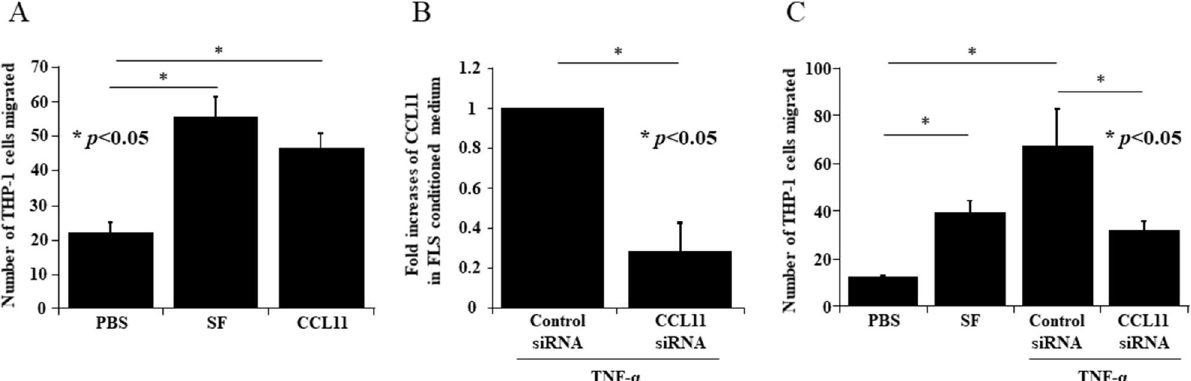
Figure 6. CCL11 induced the migration of THP-1 cells. ( A ) CCL11-stimulated THP-1 cells were significantly more efficient at migration than unstimulated cells (n = 4 experiments). SF synovial fluid. ( B ) CCL11 siRNA treatment decreased the secretion of CCL11 in TNF-α-treated RA FLS-conditioned medium (n = 3 patients). ( C ) CCL11 siRNA-transfected and TNF-α-stimulated RA FLS-conditioned medium reduced THP-1 migration compared to control siRNA-transfected and TNF-α-stimulated RA FLS-conditioned medium (n = 4 patients). The data are expressed as the mean ± SEM. * p < 0.05 was